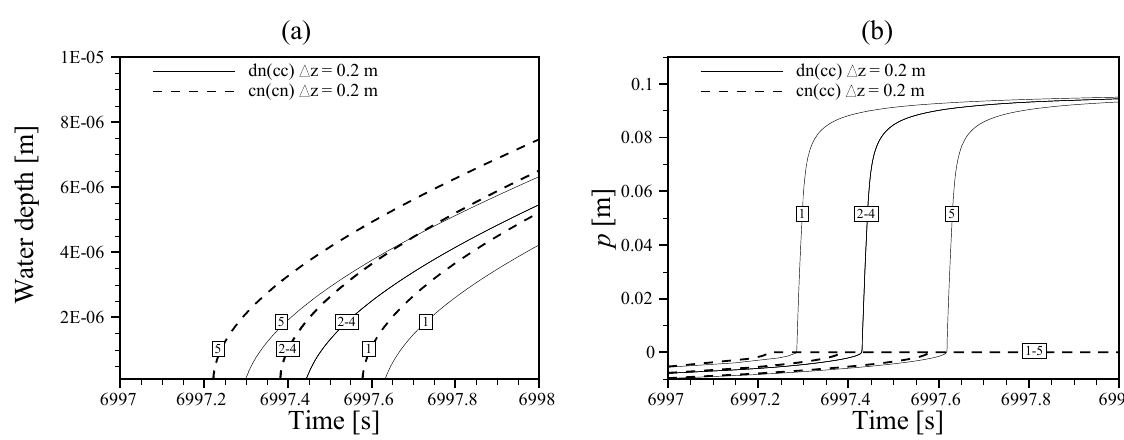
Figure 5. Simulated values for excess saturation on a hillslope (first scenario) with a cell-centered scheme and (cid:49)z = 0.2m. (a) Water depths at the surface nodes. (b) Pressure heads at the topmost subsurface nodes. Nodes are numbered 1–5 in the downslope